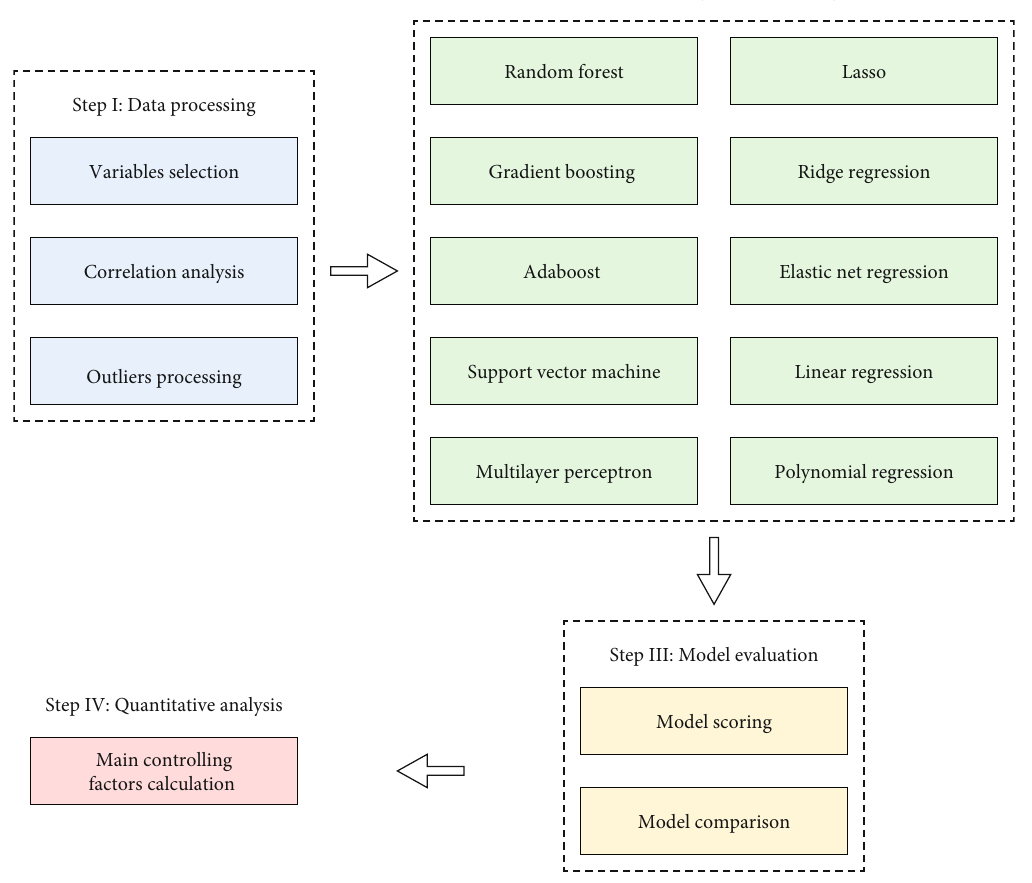
Figure 1: Work fl ow of the proposed